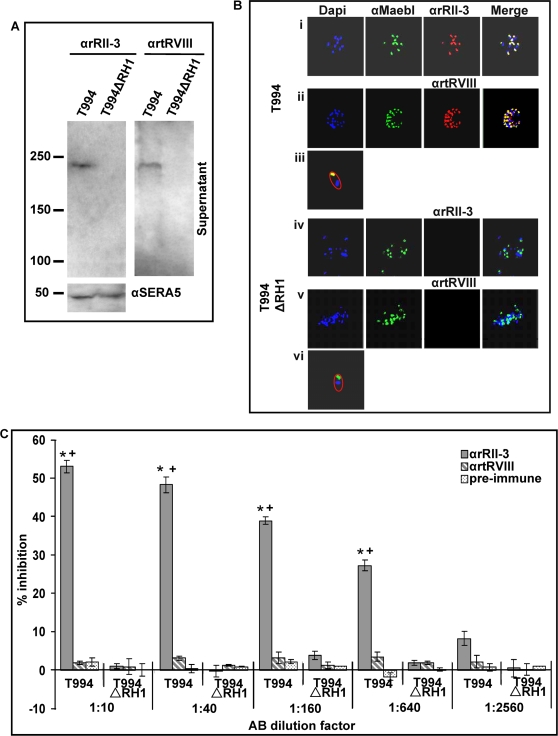
The specificity of mouse polyclonal antisera αrRII-3 and αrtRVIII Immunoblots and single-staining IFA of W2mef with.(A) Western analysis of PfRH1 expression on enriched culture supernatant from T994 and T994ΔRH1 probed with αrRII-3, αrtRVIII and αSERA5 as loading control. The expected protein of about 240 kDa was only detected by both antisera in T994 parasites. Molecular sizes are indicated on the left (in kDa). (B) Double-staining IFAs of T994 and T994ΔRH1 parasites. T994 (panel i, ii and iii) and T994ΔRH1 (panel iv, v and vi). Smear of late stage schizonts and free merozoites were reacted with rabbit polyclonal antiserum αMaebl (second column); αrRII-3 or αrtRVIII (third column). Parasite nuclei are stained with DAPI (blue). For each panel, Alex Flour 488 goat anti-rabbit IgG (H+L) (green) are to rabbit serum, and Alex Flour 594 goat anti-mouse IgG (H+L) (red) to mouse sera. In the merged images, areas of overlap between the red and the green signals are shown in yellow. The outline of single merozoite (panel iii and vi) is shown separately. (C) Comparison of merozoite invasion inhibition with αrRII-3 and αrtRVIII, including pre-immune serum in 1∶10 to 1∶2560 dilutions in T994 and T994ΔRH1. The error bar denotes the SE. * p<0.001, indicating that αrRII-3 successfully blocked the invasion in T994 parasites, compared to the invasion in T994ΔRH1 with different dilutions. + p<0.001, indicating that αrRII-3 significantly inhibited the invasion compared with αrtRVIII and pre-immune serum.